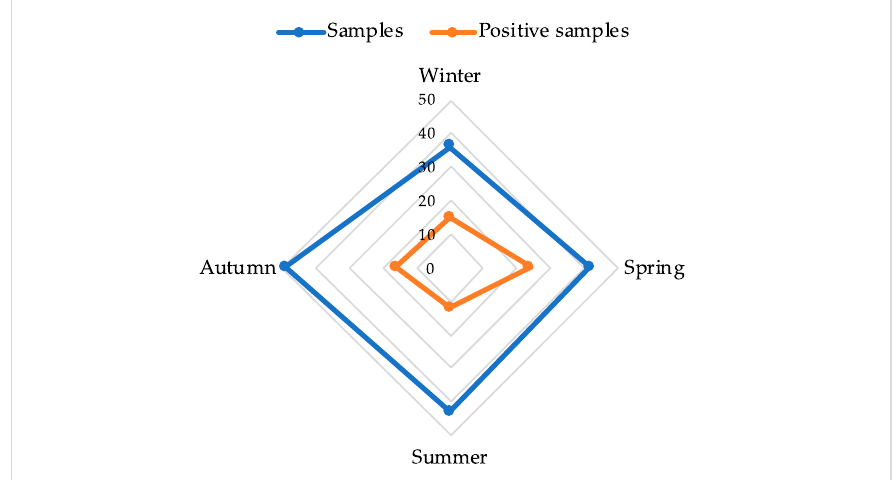
Figure 3. Distribution of total (blue line) and positive samples (orange line) in the seasons of the year. Data are shown as absolute numbers.